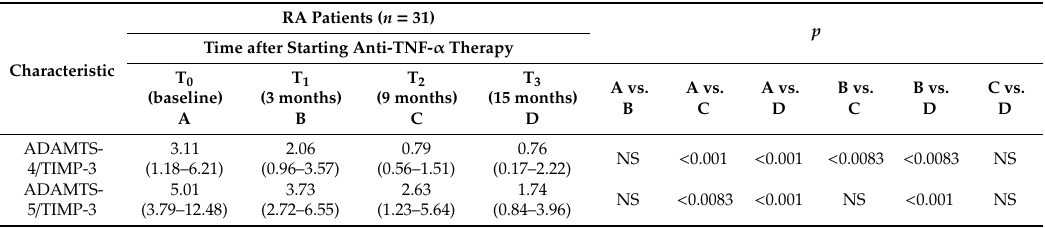
Table 4. Concentration ratios of ADAMTS to TIMP-3 in RA patients before and during 15-month anti-TNF-α therapy.